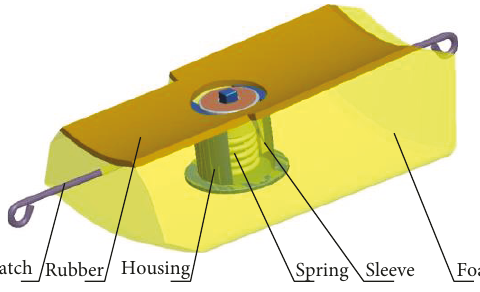
Figure 2: Structure of the